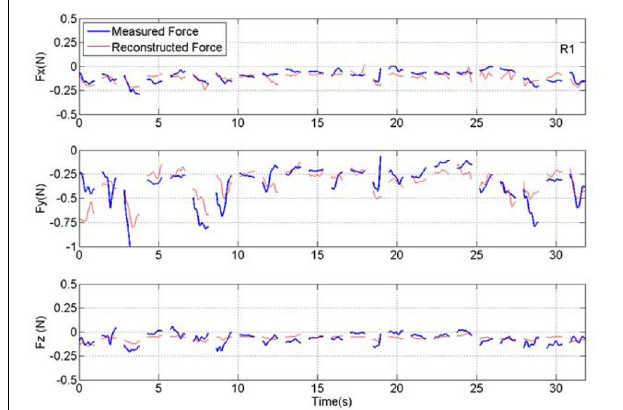
FIGURE 7 | Plot of measured and reconstructed forces in all three directions in a set of 23 test trials from rat #1 (R1). Measured force is shown in blue and the force reconstructed from the neural signal is shown in red. Discontinuities in the plots separate the isometric force segments taken from different trials. The correlation values are 0.65, 0.73, and 0.52 for X , Y , and Z directions respectively. The R 2 numbers are 0.35, 0.52, and 0.26 in the same order.